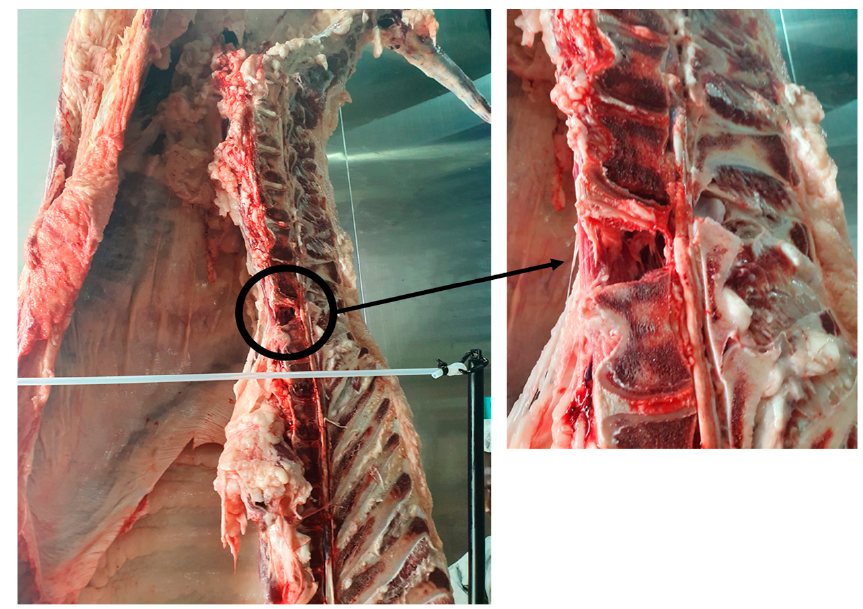
Figure 12. Carcass damage due to motor rotation.